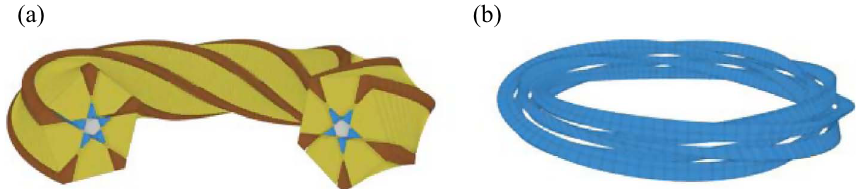
Figure 7. (a) Pentagonal GML body. (b) One of the resulting a number of disconnected shapes, ten triangular or quadrangular shapes (either blue as in Fig. 7b or brown) and six pentagonal shapes (in grey and yellow).